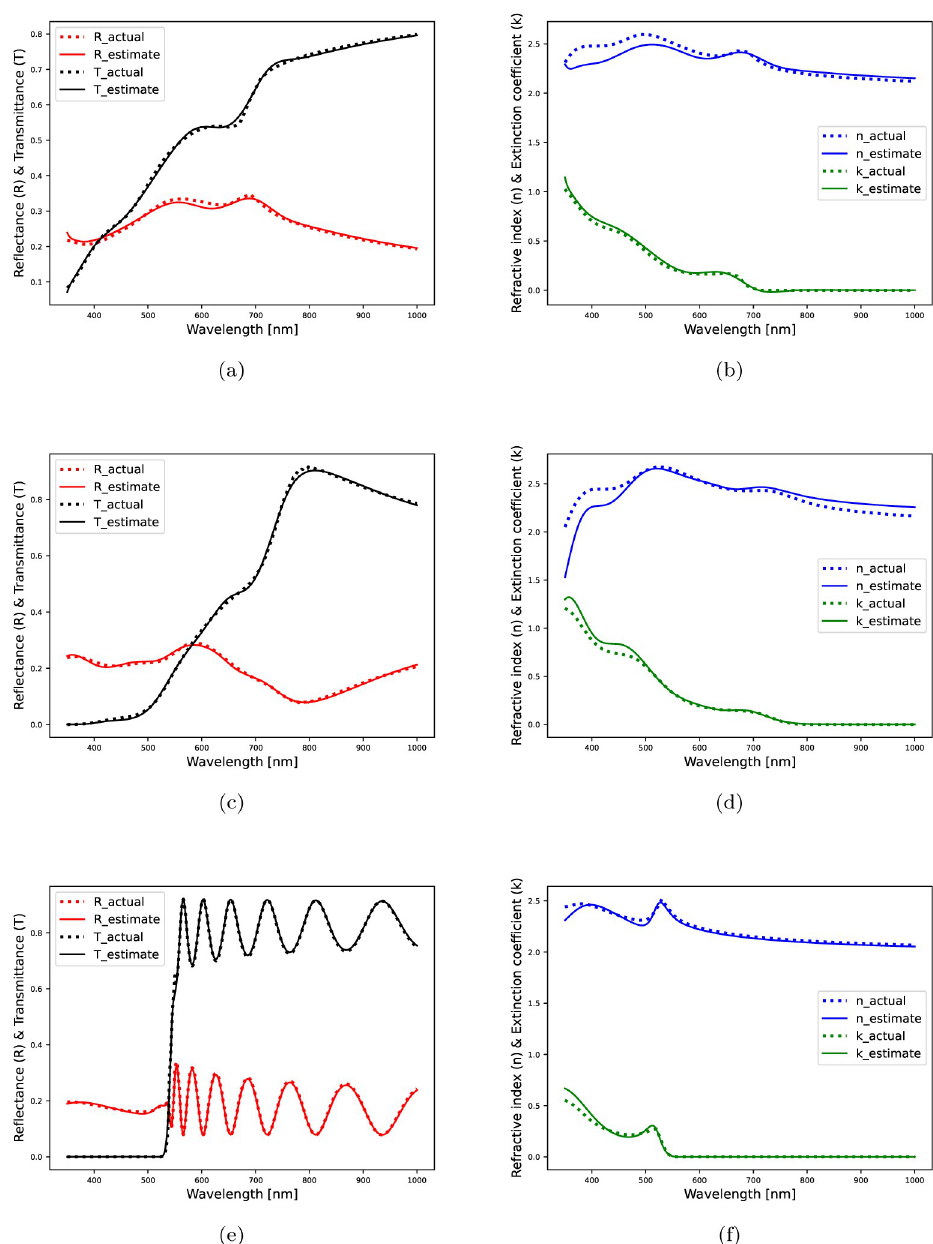
Fig 4. Inverse solutions obtained using the semi-synthetic spectral data of MAPbI3 films: (a) Actual and estimated spectra with optimized GO ensemble; total estimation loss = 0.0530, (b) Actual and estimated optical constants with GO; actual and estimated thickness = 62.0, 59.44 nm , (c) Actual and estimated spectra with optimized GO ensemble; total estimation loss = 0.0454, (d) Actual and estimated optical constants with GO; actual and estimated thickness = 169.0, 166.53 nm , (e) Actual and estimated spectra with optimized TLO ensemble; total estimation loss = 0.0335, (f) Actual and estimated optical constants with TLO; actual and estimated thickness = 1350.0, 1359.86 nm